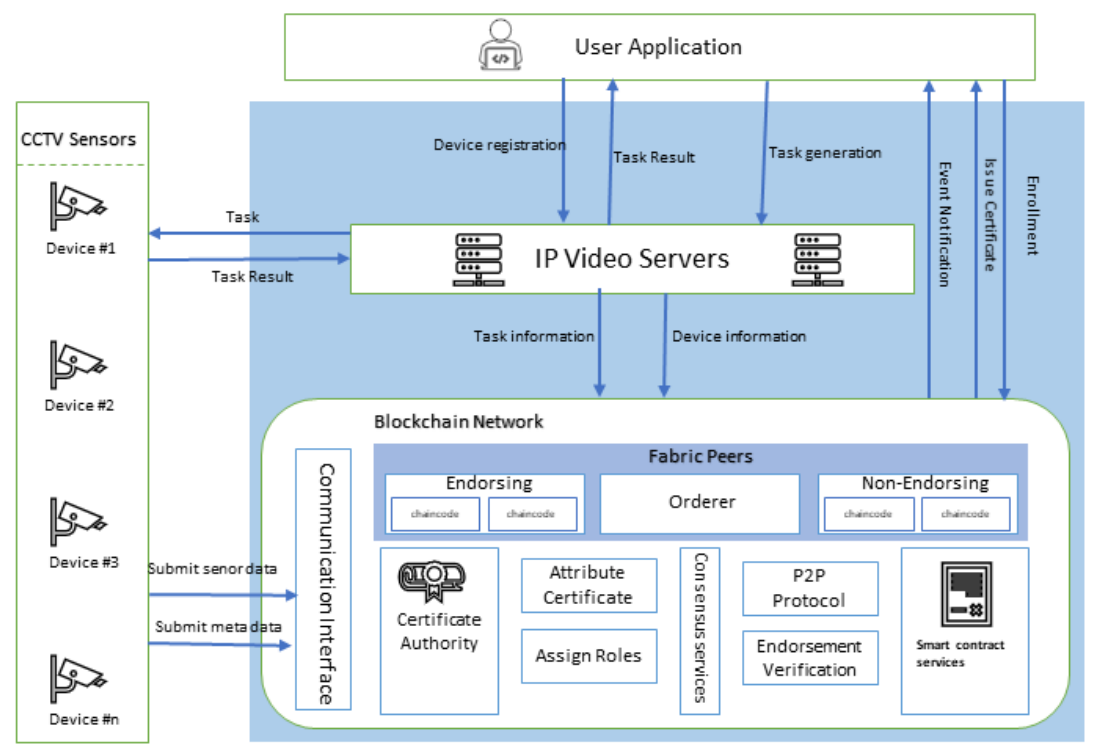
Figure 7. System model of the proposed CCTV-Blockchain platform.